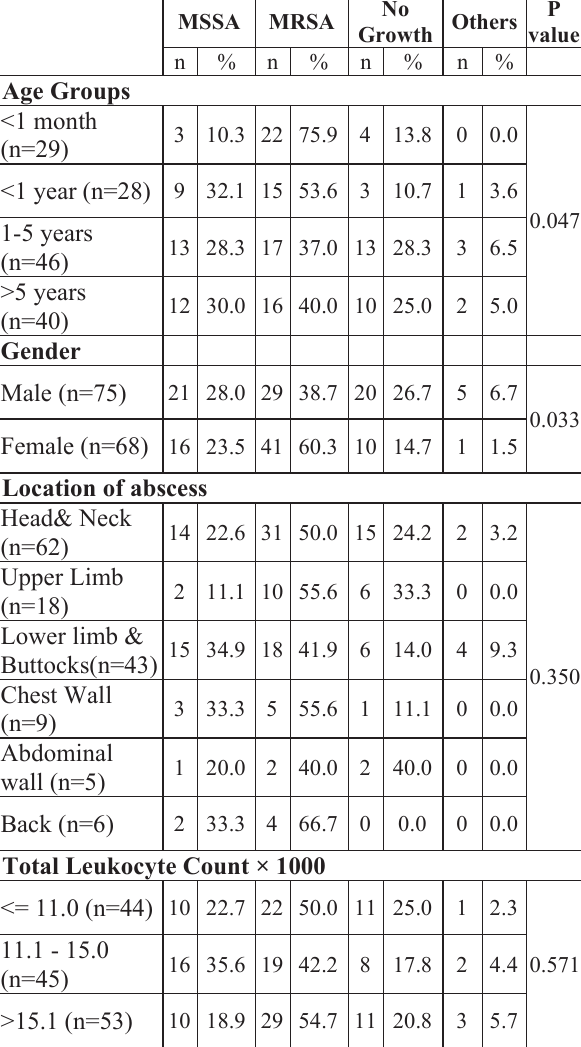
Table-3: Comparison of patient parameters with type of